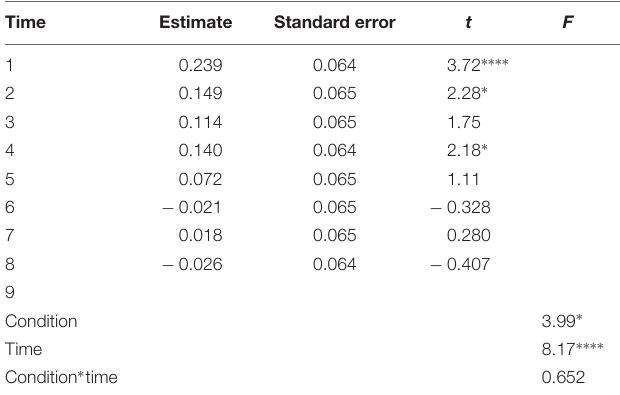
TABLE 4 | The effect of smartphone restriction on fear of missing out (FoMOS) scores by linear mixed models. Time